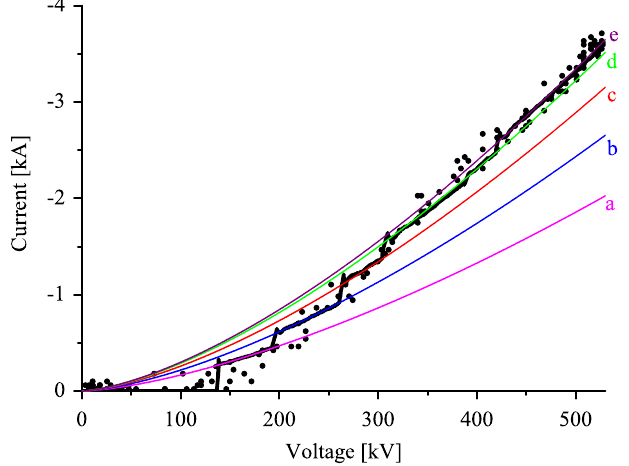
FIG. 6. (Color) Current expressed with respect to voltage. Dots are the measured result and the thick solid curve is the MAGIC2D result. Other solid curves represent the characteristic perveances satisfying Child-Langmuir law: (a) 5 : 25 (cid:1) P , (b) 6 : 88 (cid:1) P , (c) 8 : 17 (cid:1) P , (d) 9 : 11 (cid:1) P , and (e) 9 : 45 (cid:1) P .